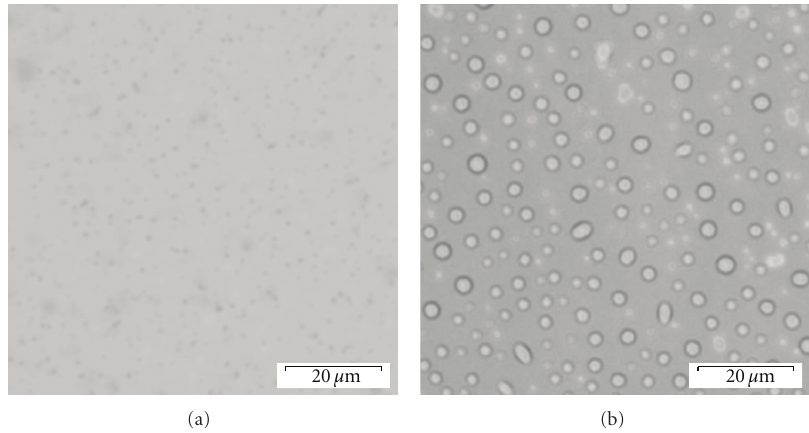
Figure 3: Optical microscope images of (a) PBS8T film and (b) film obtained from TEOS and 8T